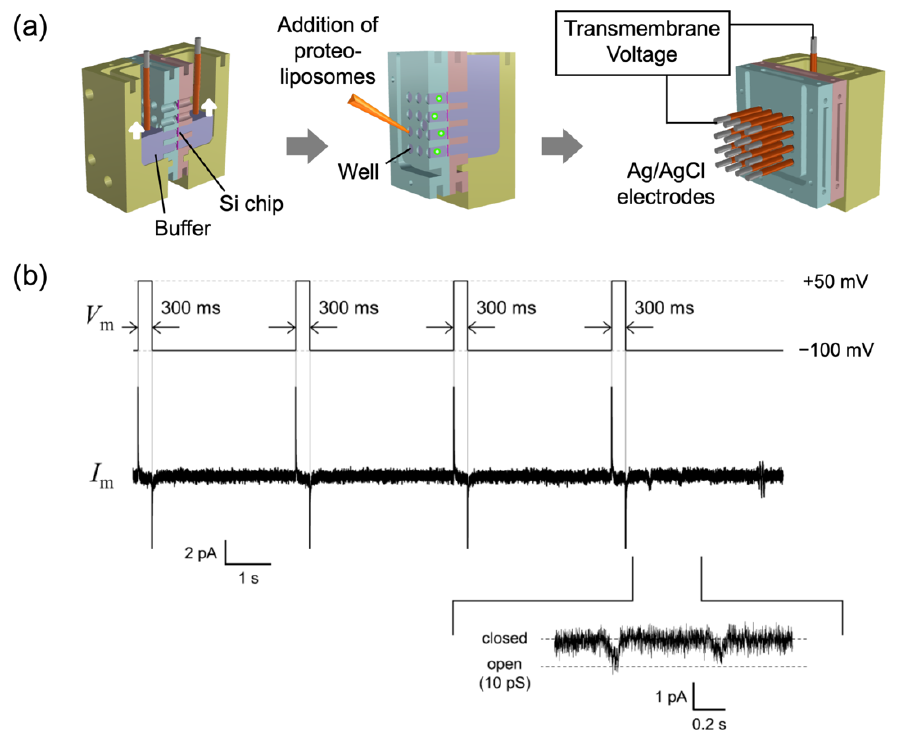
Figure 5. ( a ) Schematic images of a 16-well BLM analysis system; ( b ) an example of hERG